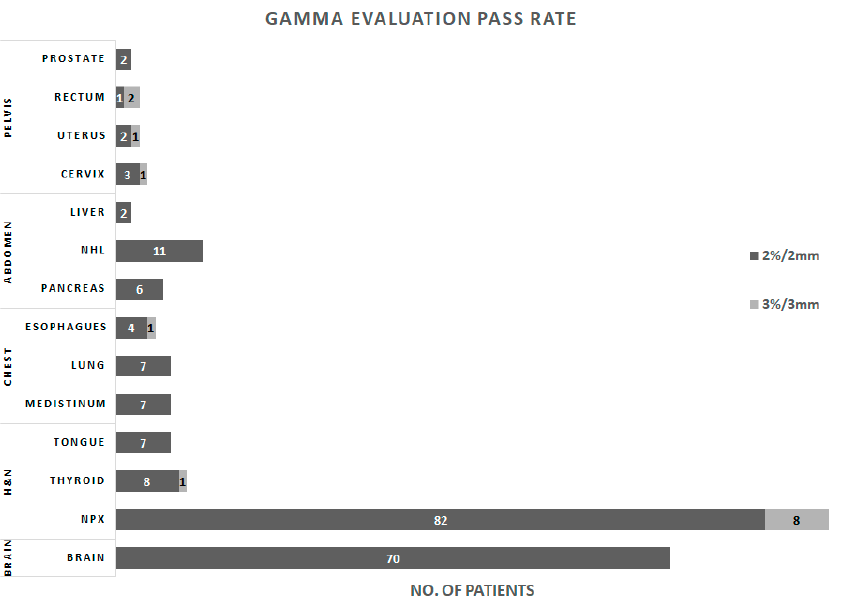
Figure 6. 3D gamma index pass rate for the all sites with criteria 2 mm/2% and 3 mm/3%.